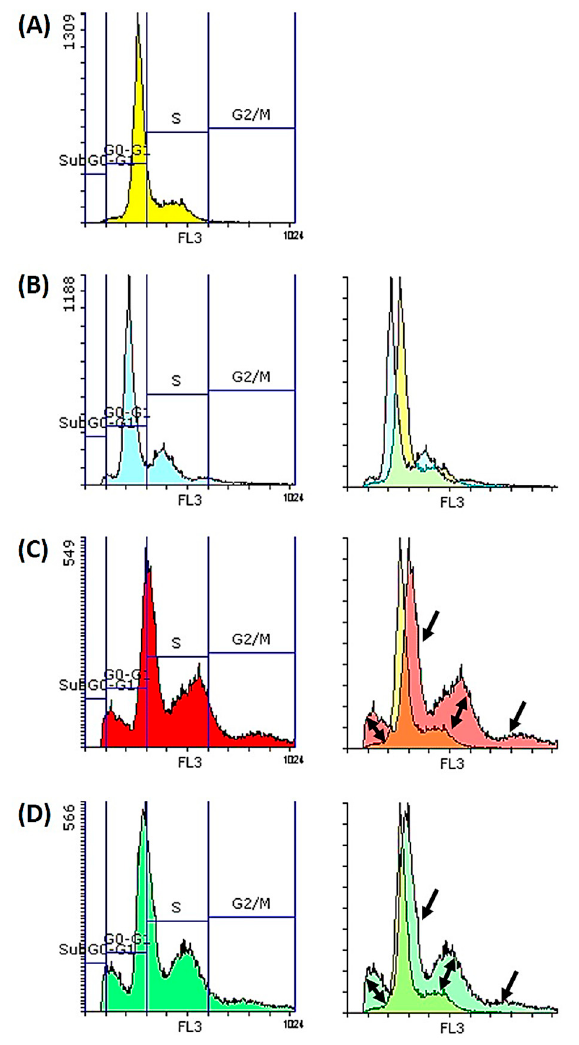
Figure 3. Cell cycle analysis (DNA analysis) of Caco-2 cells treated for 24 h with IC 50 of retinoids. The histograms of ( A ) negative control exposed to 0.1% DMSO solvent (yellow histogram), ( B ) ATRA (blue histogram), ( C ) EC19 (red histogram), and ( D ) EC23 (green histogram) are shown, together with the overlay histograms of each synthetic retinoid compared to the solvent control. Regions of cell cycle arrest are indicated with black arrows reflecting the early apoptosis compared to control.